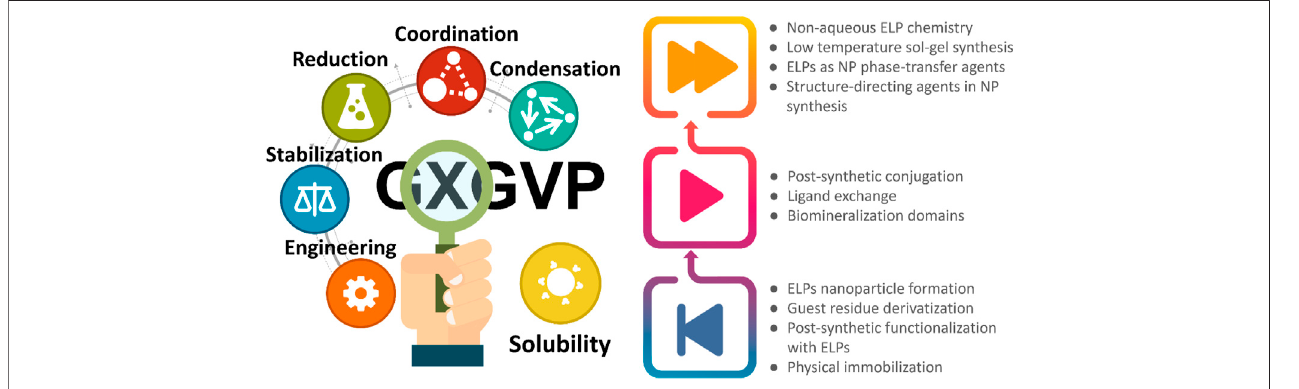
FIGURE1| ThevarietyofguestresiduesthatcanbetailoredinthepolypeptidesequenceenrichthecapabilitiesofELPs,bringingmanyopportunitiesfortheirusein nanoparticle synthesis (left). Summative scheme to gather the background, current status and future developments in nanoparticle synthesis through ELPs.